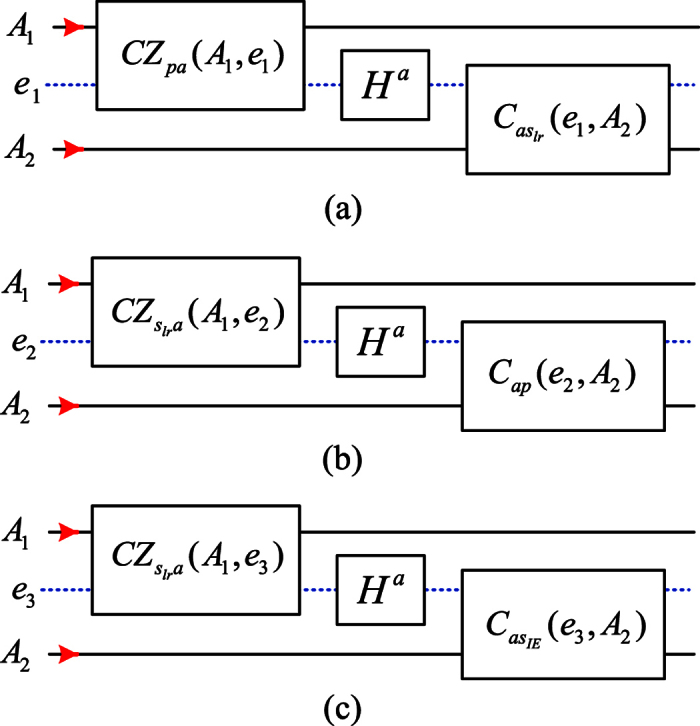
Schematic CNOT gate on different DoFs of the two-photon system.(a) Schematic CNOT gate on the polarization DoF of one photon and the spatial DoF {l, r} of the other. (b) Schematic CNOT gate on the spatial DoF {l, r} of one photon and the polarization DoF of the other. (c) Schematic CNOT gate on the spatial DoF {l, r} of one photon and the spatial DoF {I, E} of the other photon. ei denote auxiliary NV centers in the NV-cavity NVi, i = 1, 2, 3. The subcircuits Ha, CZpa, Cap, CZsa and Cas are shown in the Fig. 3.